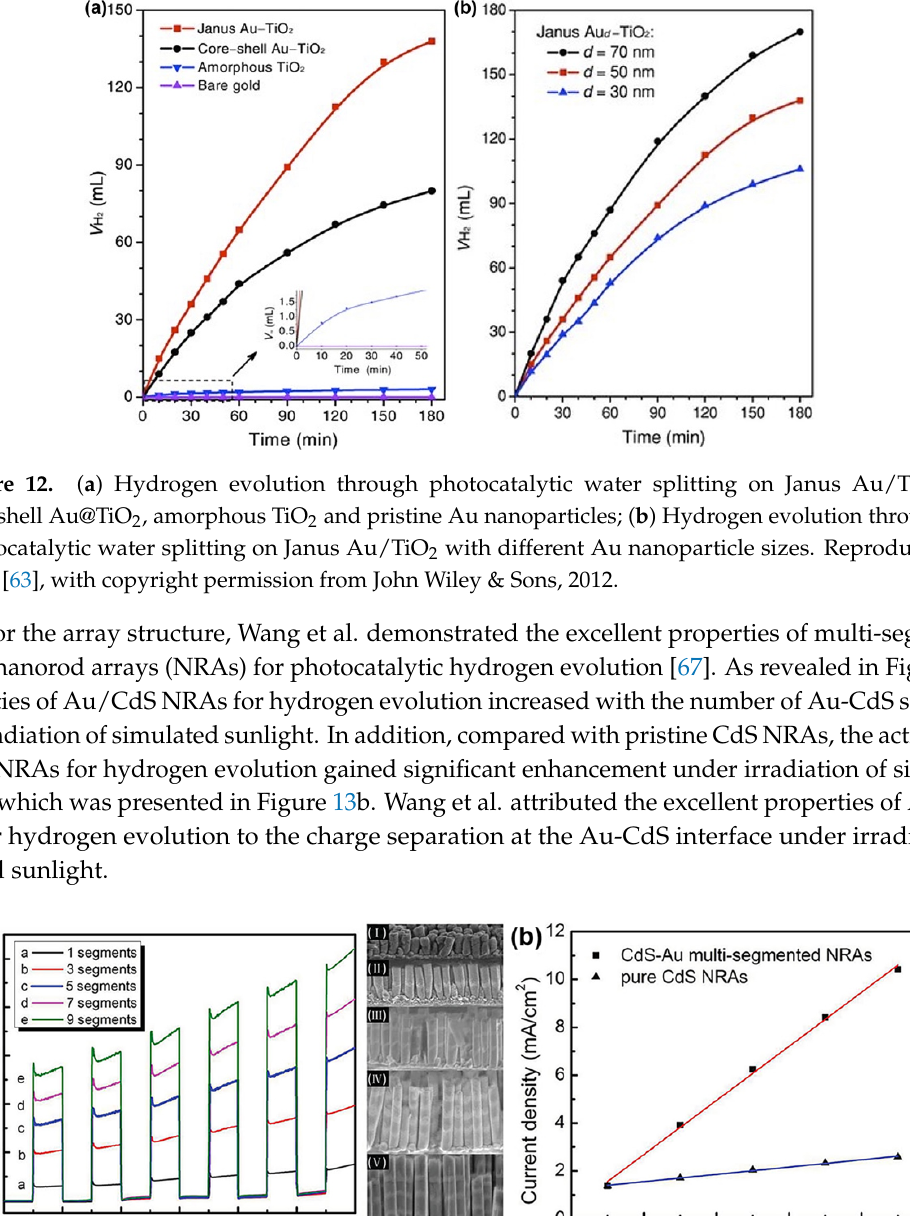
Figure 13. ( a ) Hydrogen evolution on the multi-segmented CdS/Au NRAs in the photoelectrochemical cell under irradiation of simulated sun light. (I-V) SEM images of the side view of the CdS-Au NRAs. ( b ) Comparison of the activities for hydrogen evolution on the CdS/Au NRAs and pristine CdS NRAs under irradiation of simulated sunlight. Reproduced from [67], with copyright permission from John Wiley & Sons, 2014.